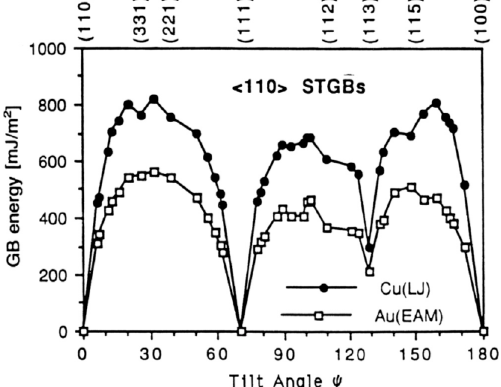
Figure 4. The correlation between grain boundary energies and misorientation angles of <110> symmetrical tilt boundaries in fcc metals (Cu and Au). (Reprinted from Reference [26], with permission from Elsevier).